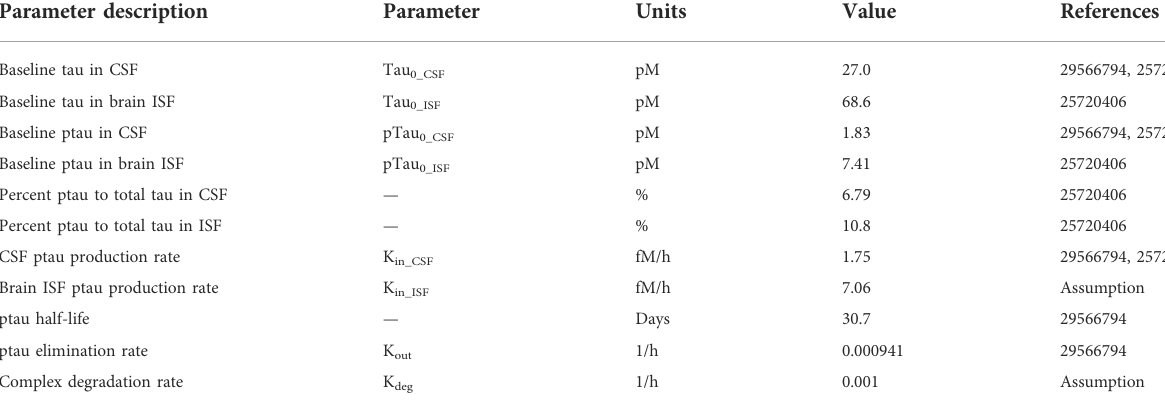
TABLE 1 PBPK-PD model parameters for tau expression and turnover in humans.